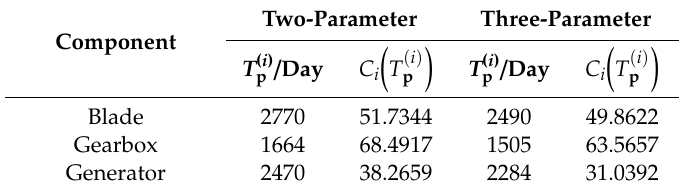
Table 6. Optimal maintenance time and maintenance cost of unit components.